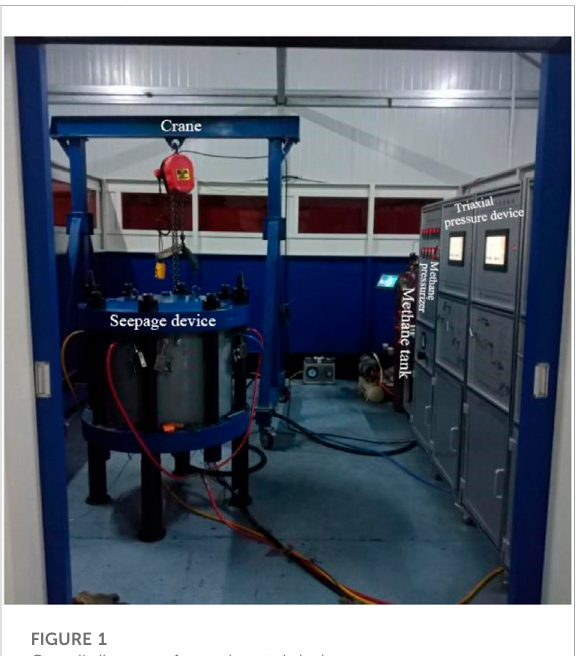
FIGURE 2 Core part of gripper. Note: The arrow stands for the gas seepage